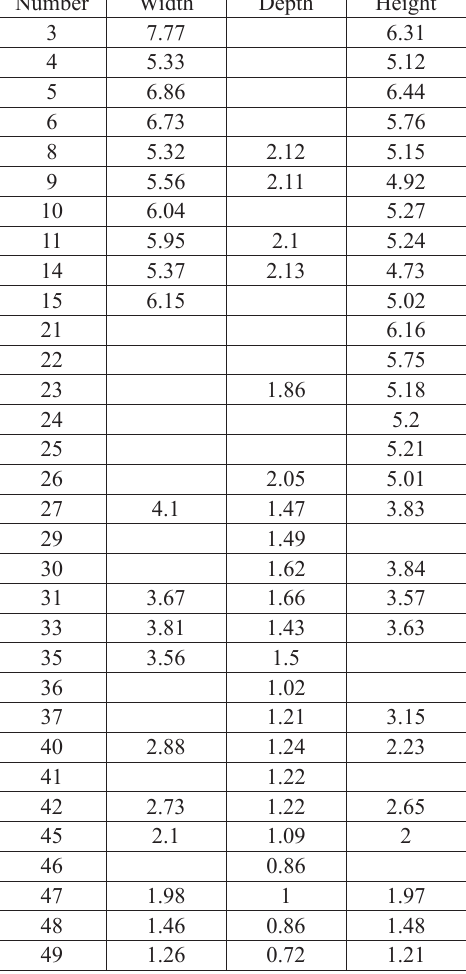
Table 1. Measurements (in cm) of preserved vertebral centra of Carcha- romodus escheri (Agassiz, 1843). Numbers refer to individual vertebral